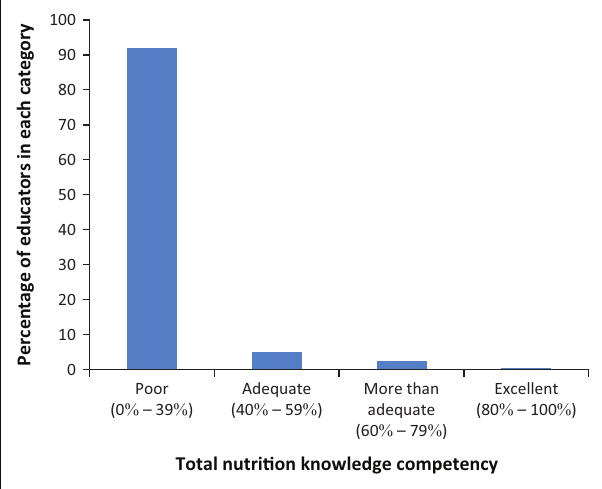
FIGURE 7: Total nutrition knowledge competency scores